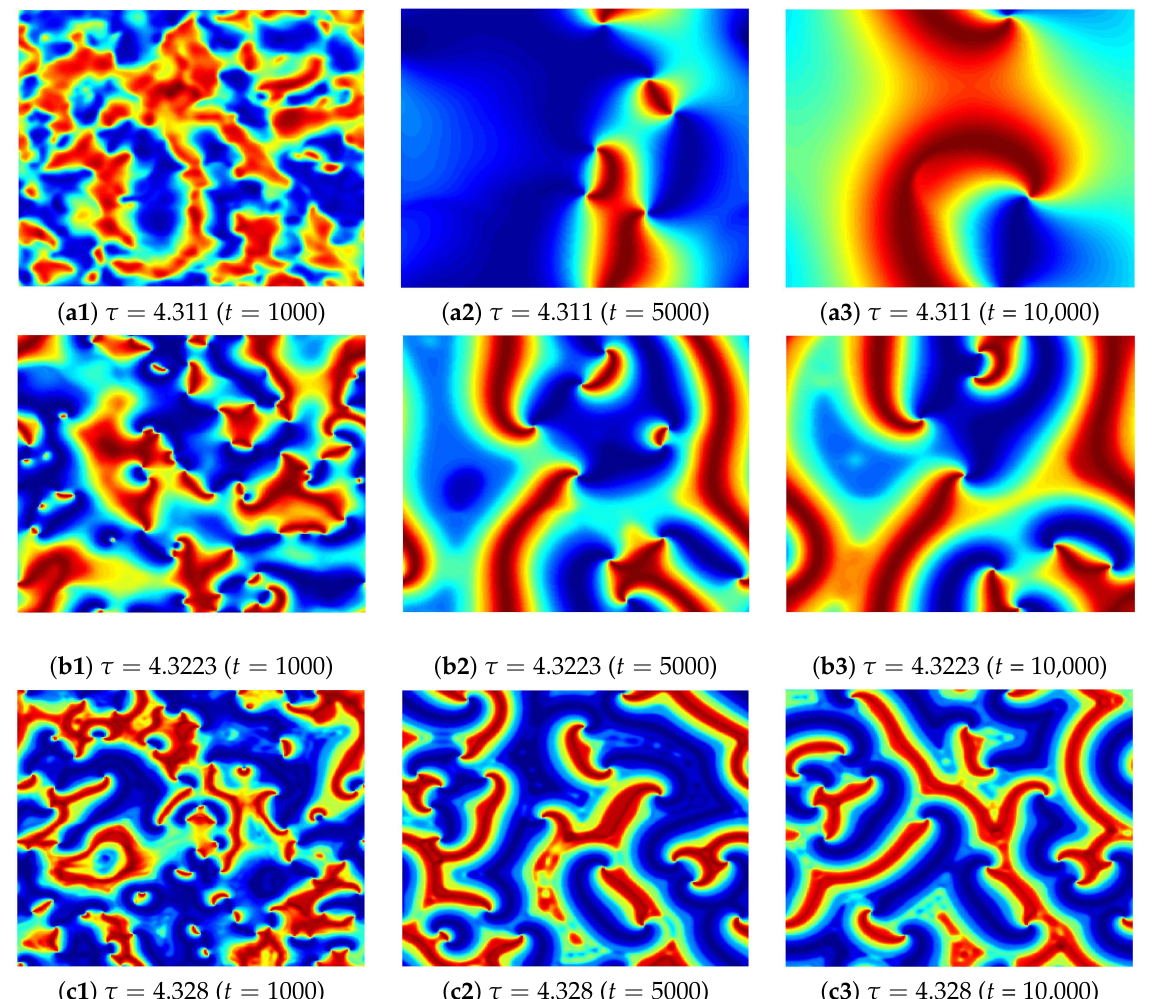
Figure 7. The patterns for Neimark-Sacker Turing